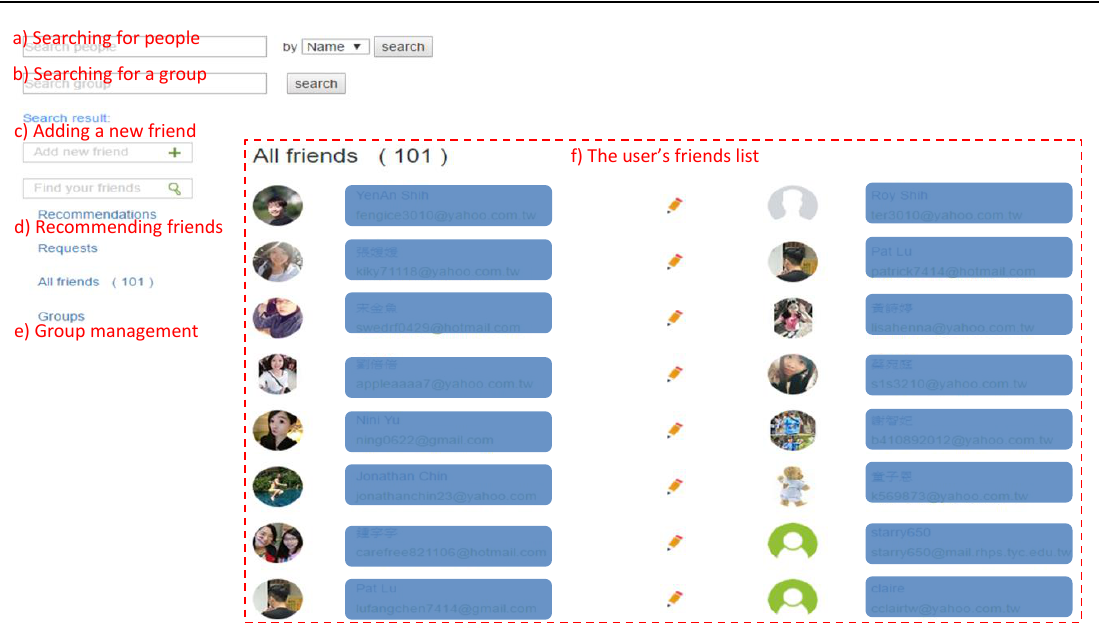
Figure 4. Social network organization function